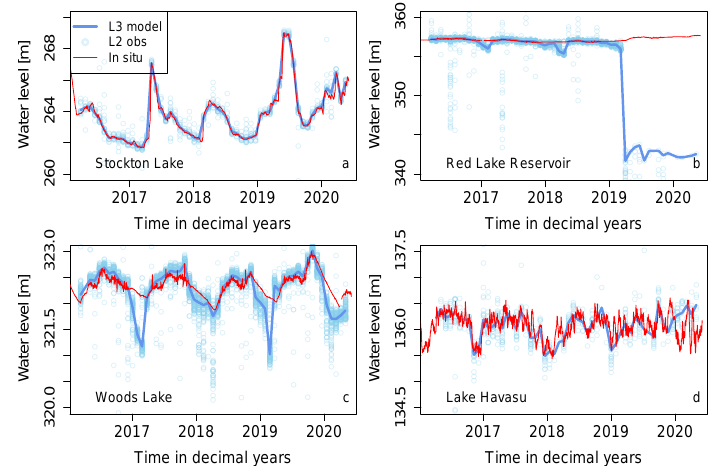
Figure 4. Lake level time series for selected US lakes ( a ) Stockton Lake, ( b ) Red Lake Reservoir, ( c ) Woods Lake, and ( d ) Lake